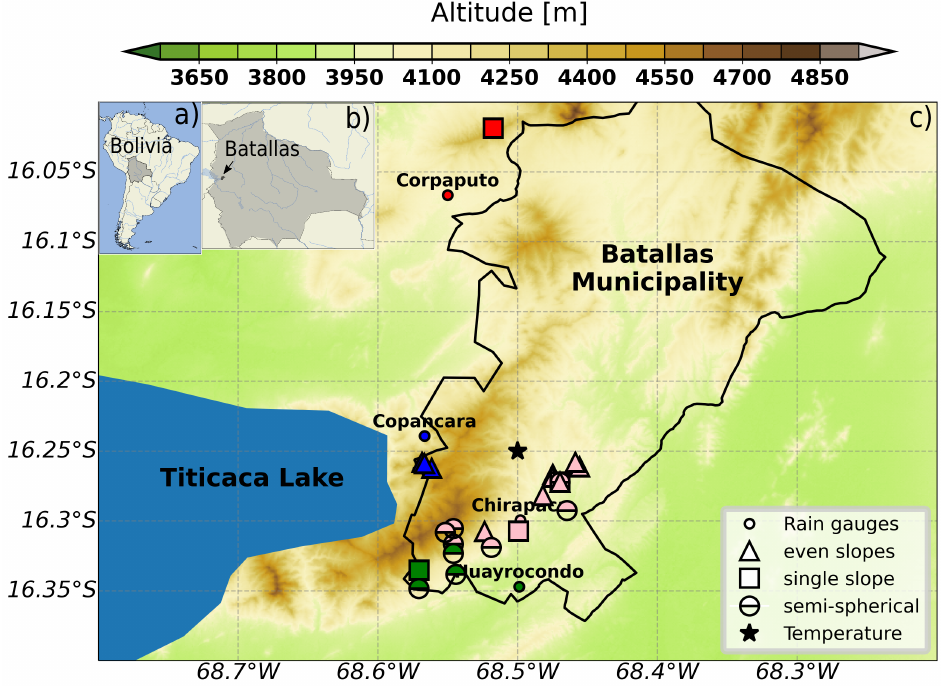
Figure 1. ( a ) Map of South America with Bolivia highlighted. ( b ) Map of Bolivia with Batallas Municipality detailed. ( c ) Altitude map of Batallas Municipality and surroundings. Greenhouses are depicted by triangles (even or two slopes roof), semi circles (semi-spherical roof), and squares (single slope roof). The closest rain gauges with at least 20 years of daily rainfall measurements are depicted with circles. Note that colors of greenhouses and the closest weather station are the same. Daily temperature location is depicted by a black star. The distance of each greenhouse to the closest rain gauge is shown in Table